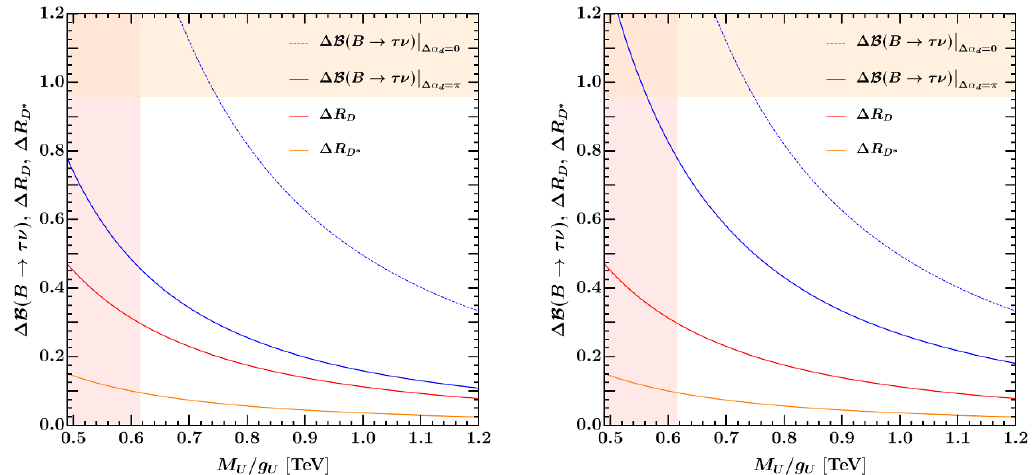
Figure 3 . NP enhancements in B ( B ! (cid:28)(cid:23) ) ; R D and R D (cid:3) as function of M U =g U . We use the following inputs: s b = 0 : 15 j V ts j (left), s b = 0 : 10 j V ts j (right), (cid:30) b = (cid:25)= 2. The red and orange bands correspond, respectively, to the 95% CL exclusion limits from LFU tests in (cid:28) decays and from B ( B ! (cid:28)(cid:23)